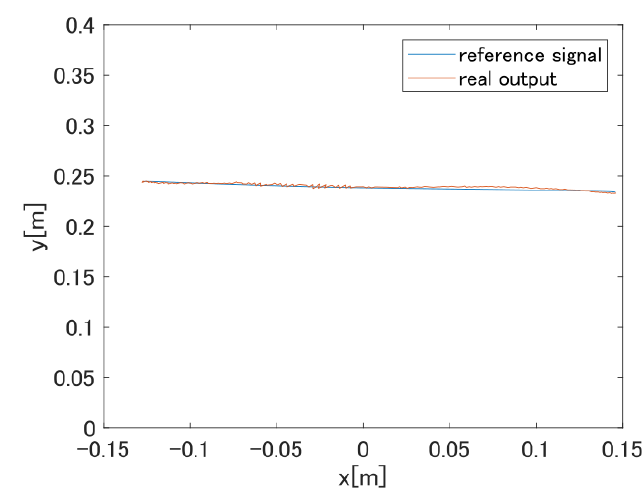
Figure 14. Multi-joint arm movement